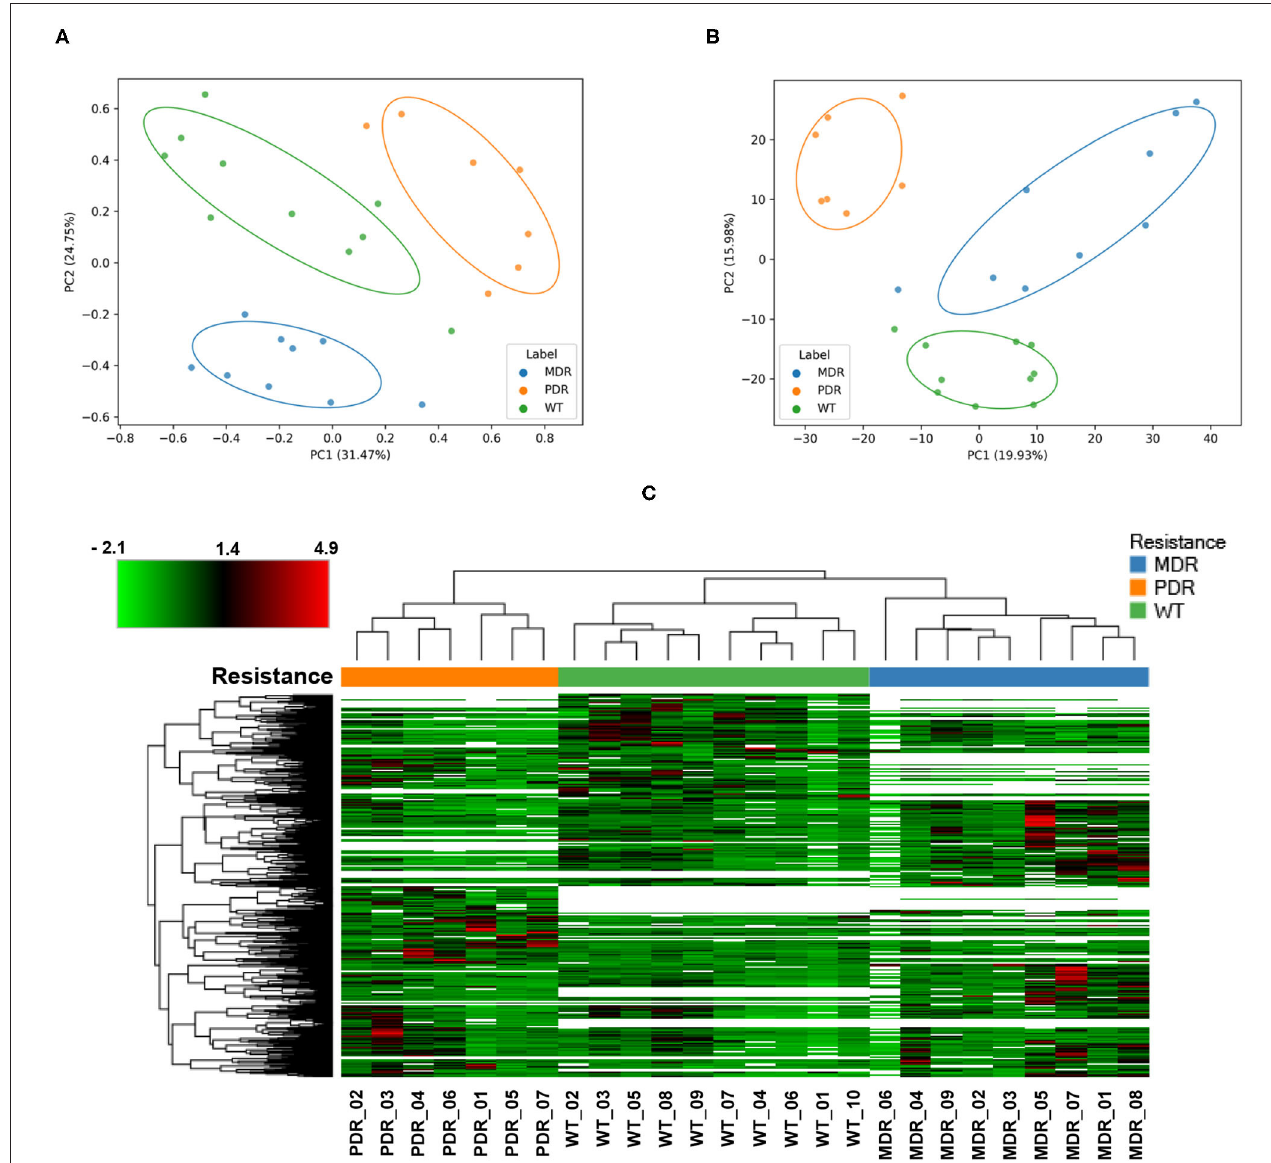
FIGURE 2 | Analyses of quantified proteins. (A) The dissimilarity between samples’ groups by the unsupervised Bray-Curtis beta diversity analysis was measured according to their proteins’ content. MDR, PDR and WT groups showed a statistically significant ( p -value ≤ 0.001) differences assessed by PERMANOVA test (PC1 vs. PC2; PC1: 31.47%; PC2: 20.75%). (B) Unsupervised Principal Component Analysis displayed a good separation amongst groups (PC1 vs. PC2; PC1: 19.93%; PC2: 15.98%). (C) Color-coded hierarchical cluster analysis visualized by the heat map based on the normalized protein abundances and applying a z-score transformation. The dendrogram above the heat map, representing the distance between samples, demonstrated good similarity among samples of each strain groups. The top left heat map color legend displays the range of the scaled protein abundance values, ranging from − 2.1 to + 4.9 and a mean of + 1.4. Blue, orange and green color of (A–C) labels/resistance profiles correspond to MDR, PDR and WT P. aeruginosa strains,